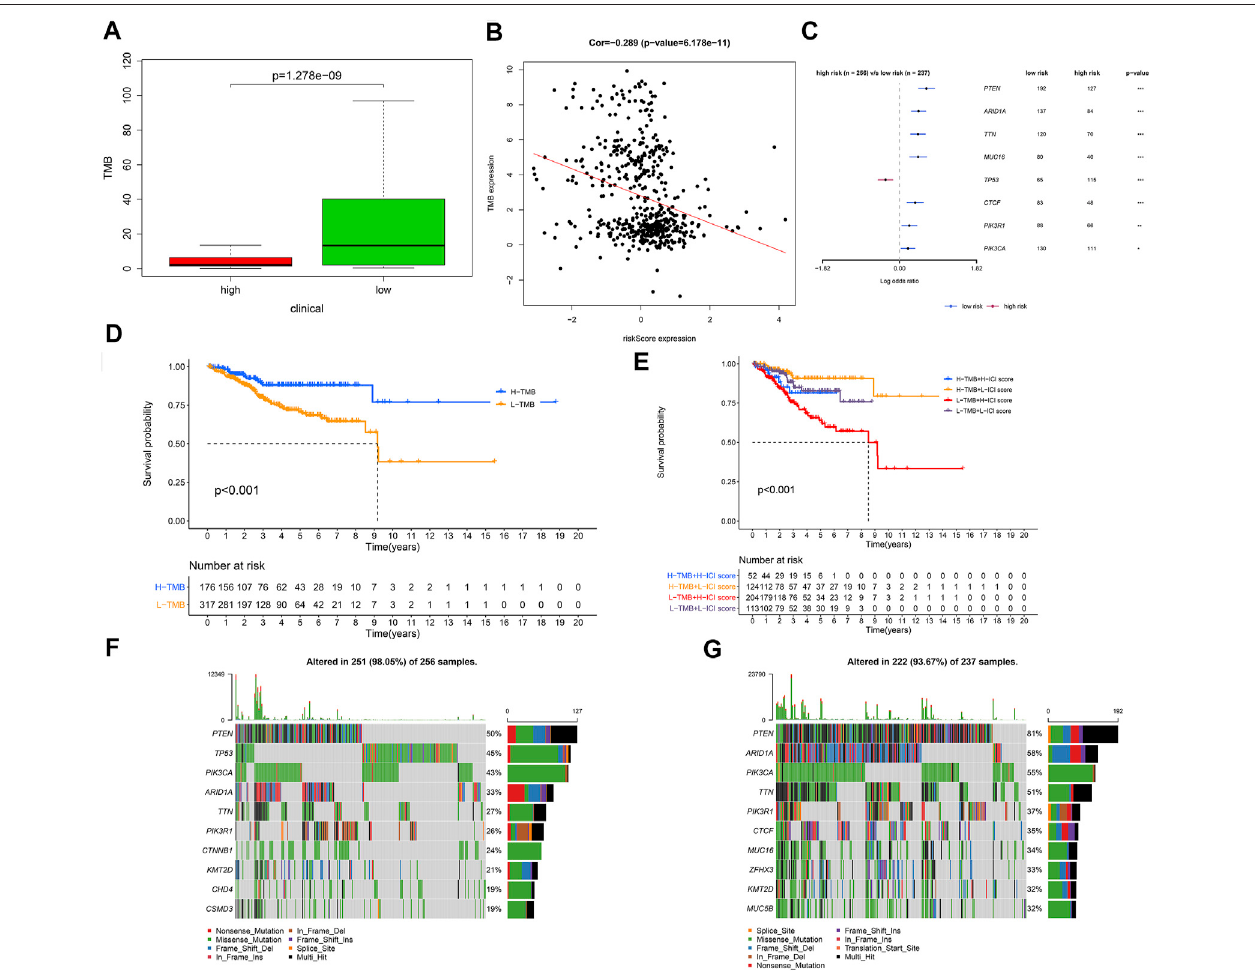
FIGURE 9 | The relationship between risk score and tumor mutational burden (TMB). (A) Comparison of TMB between the low- and high-risk groups. (B) The correlation between risk score and TMB was negative. (C) The regression analyses of the mutated genes. (D) Kaplan – Meier curves for the high and low TMB groups of theTCGA – UCECcohort.Log-ranktest, p < 0.001. (E) Kaplan – MeiercurvesforpatientsintheTCGA – UCECcohortstrati fi edbybothTMBandriskscore.Log-ranktest, p < 0.001. (F) Oncoplot displaying the somatic landscape of UCEC in the high-risk group. (G) Oncoplot displaying the somatic landscape of UCEC in the low-risk group. In the high-risk group, N (cid:1) 267; in the low-risk group, N (cid:1) 244.